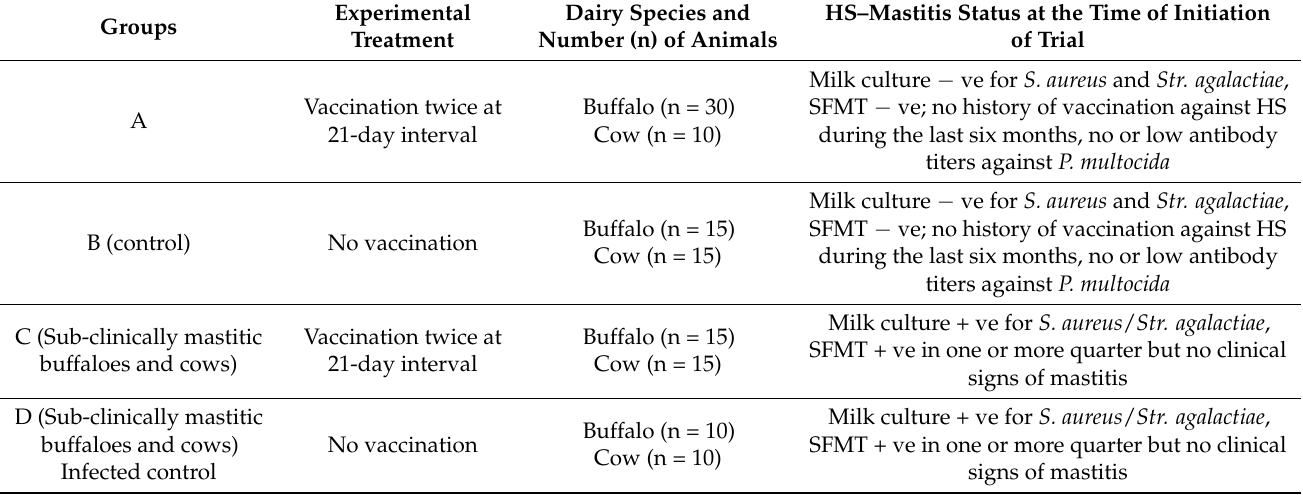
Table 1. Experimental